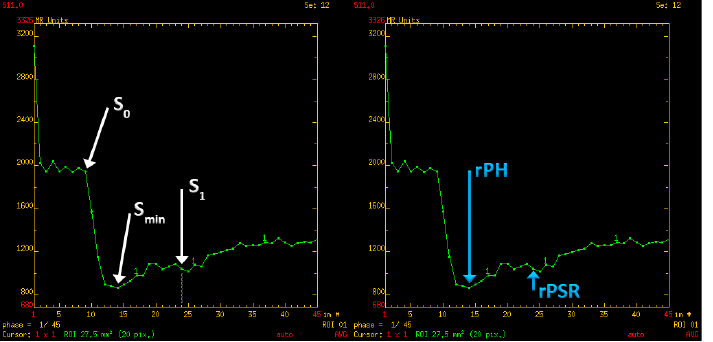
Figure 3. Perfusion curve parameters: S 0 —A baseline signal intesity; S min —minimal signal values during fi rst pass of gadolinium contrast; S 1— signal intensity recovery 14 seconds after the beginning of the signal drop; rPH—relative peak height; rPSR—relative percentage of signal recovery. signal drop; rPH—relative peak height; rPSR—relative percentage of signal